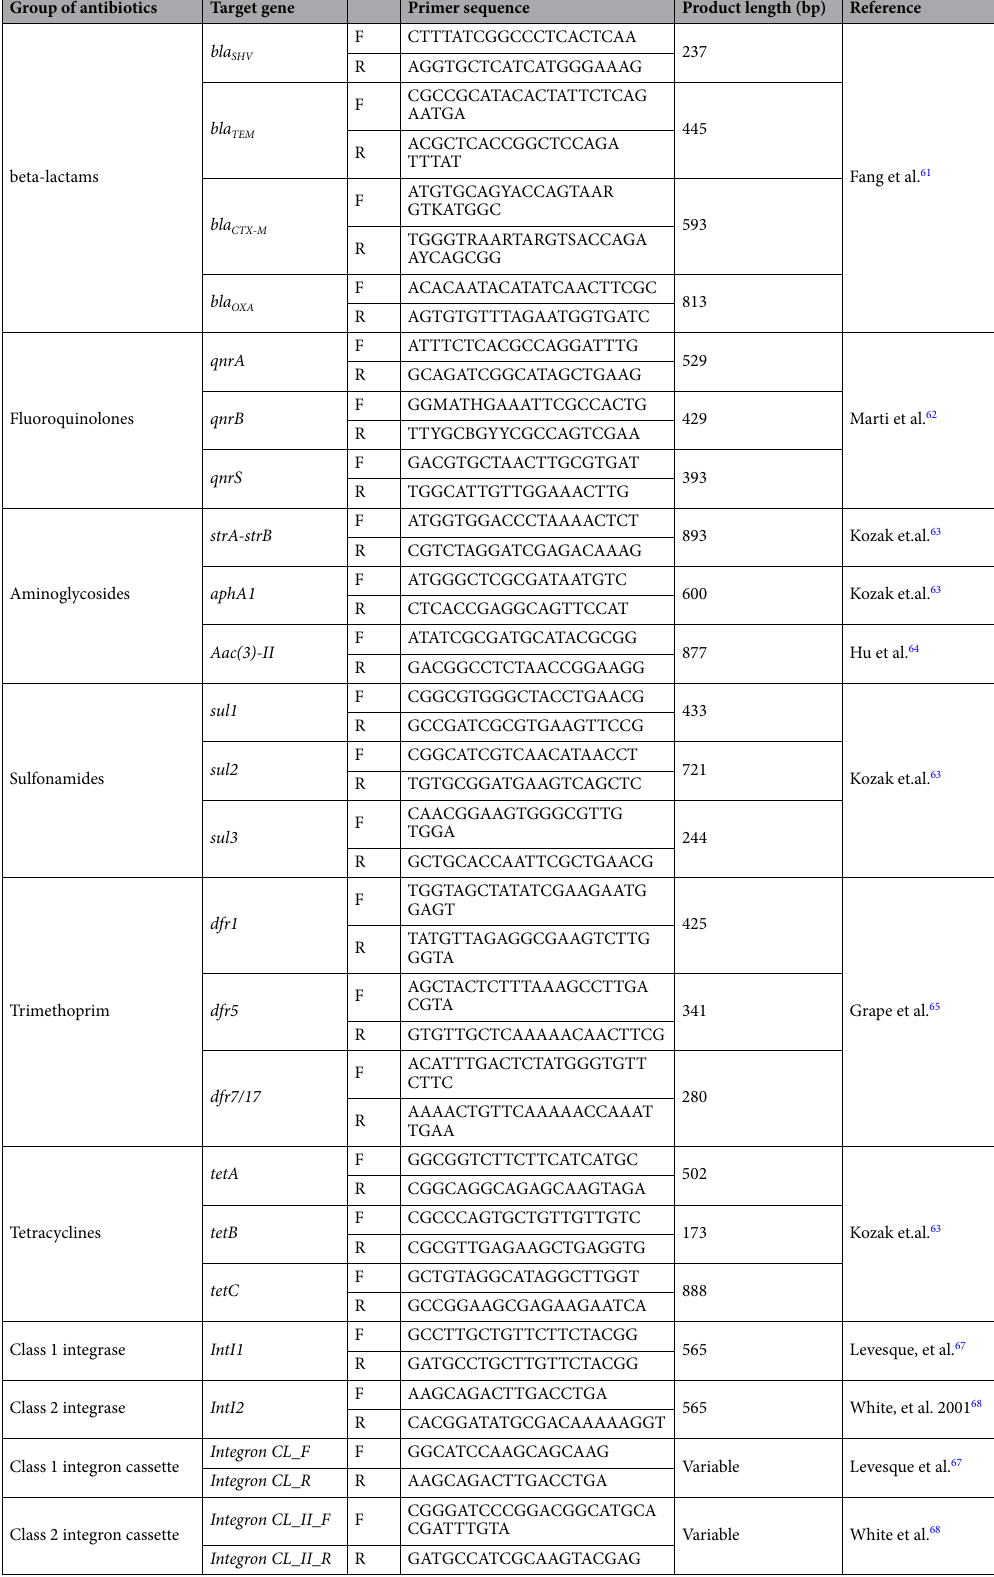
Table 6. Primer pairs used for PCR analyses in this